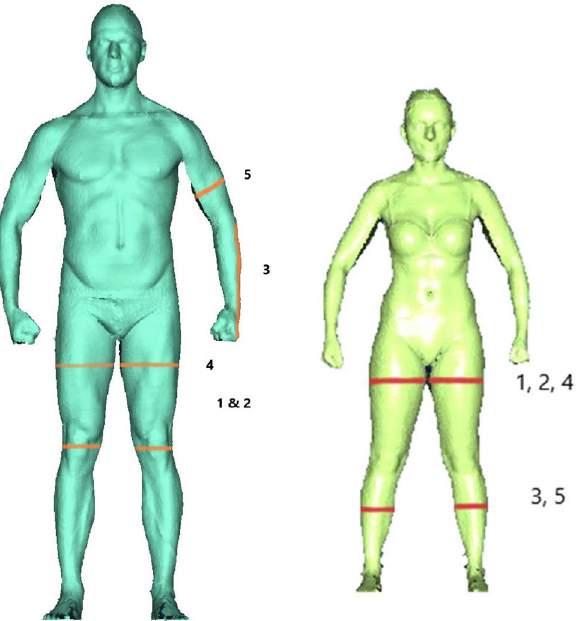
Figure 4. The five strongest related body scan markers for VO2peak (ml/min) for male and female subjects; strongest associations for men are colored in orange and for women in red. The images were provided with kind permission of the